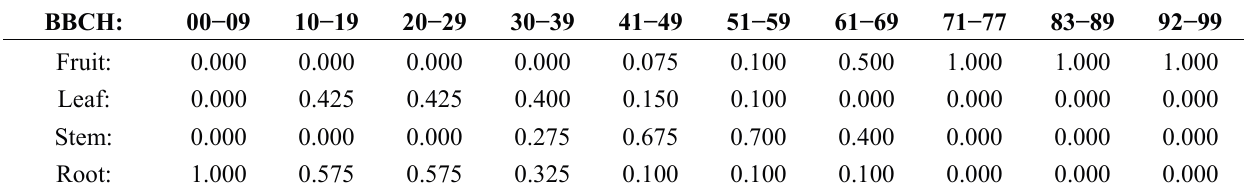
Table 2. Partitioning coefficients used for the allocation of assimilates into the winter wheat canopy fractions in dependence of the BBCH growth